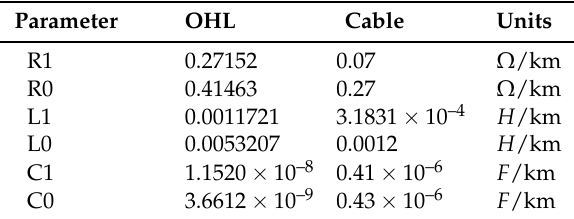
Table 3. The overhead and cable line parameters.